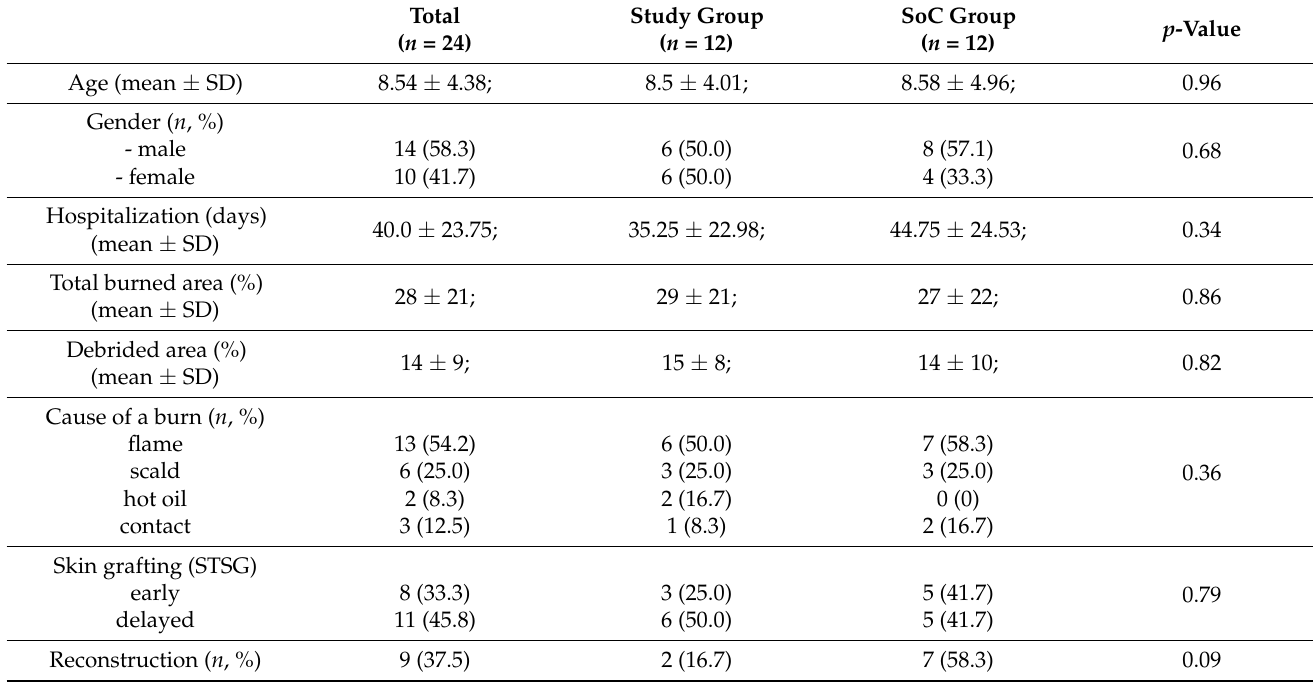
Table 3. Comparison of results between study and SoC